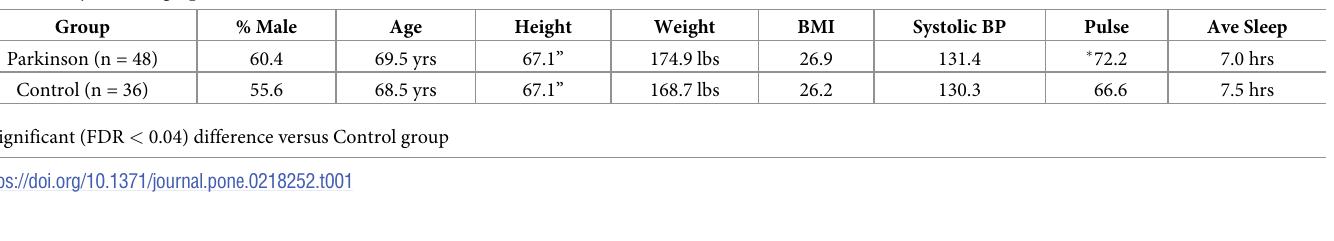
the overall trend when the full group scores were available was for reduced balance scores in the PD group. Reaction times and cognitive scores. PD subjects demonstrated a consistent decrease in their simple and complex reaction time measures compared with Controls, as reflected in reduced performance on the SRT, PRT and GNG tasks (Table 3). Consistent with the slowed reactions times, we also observed that PD subjects took longer to complete the Trailmaking A and B tasks, and this was accompanied by reduced scores on these measures as well (Table 3).